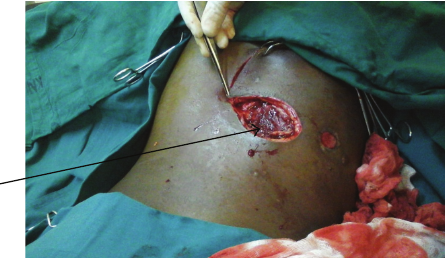
Figure 3: Island latissimus dorsi segmental muscle flap.